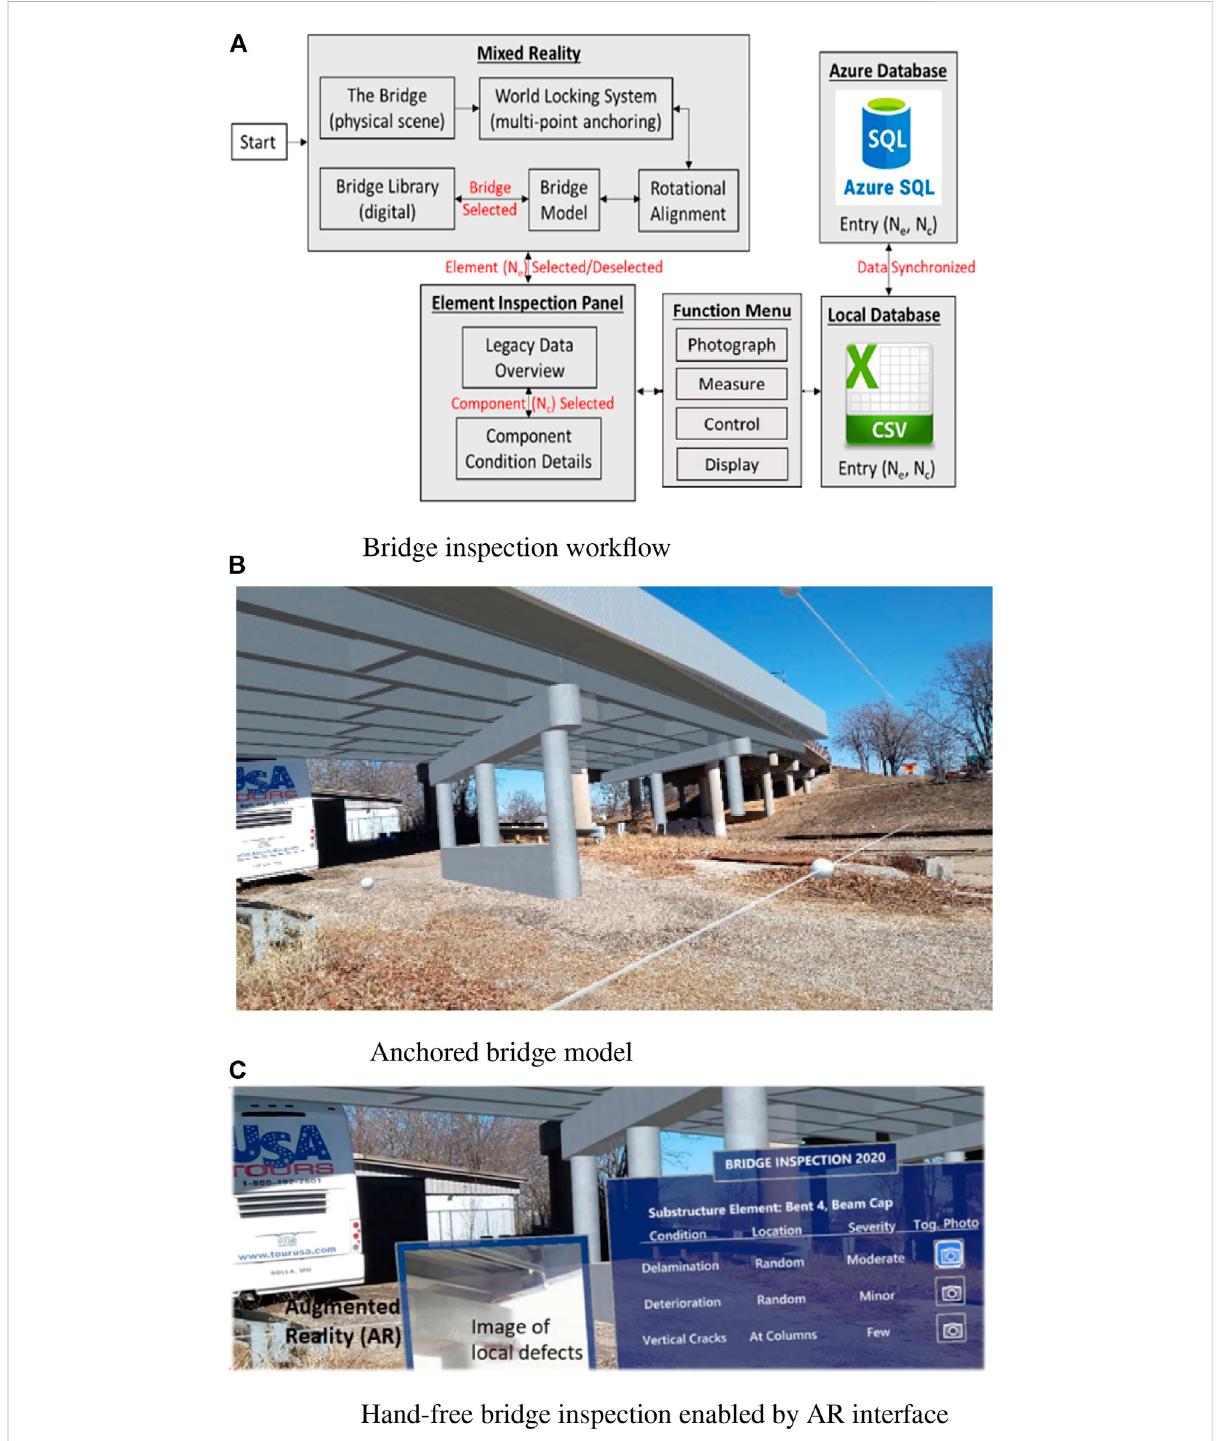
FIGURE 9 Development of AR-assisted bridge inspection platform (Li and Chen 2022). (A) Bridge inspection work fl ow. (B) Anchored bridge model. (C) Hand-free bridge inspection enabled by AR